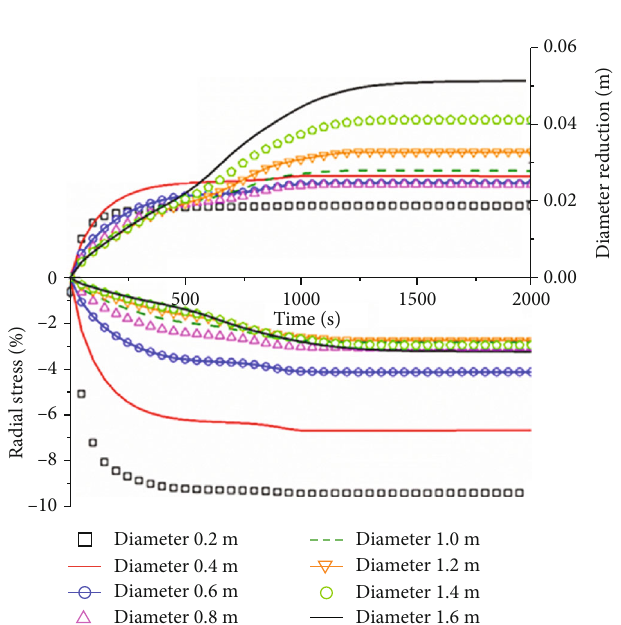
Figure 12: Relationships between radial strain, diameter reduction, and time under di ff erent initial borehole diameters (depth 200 mbsf).